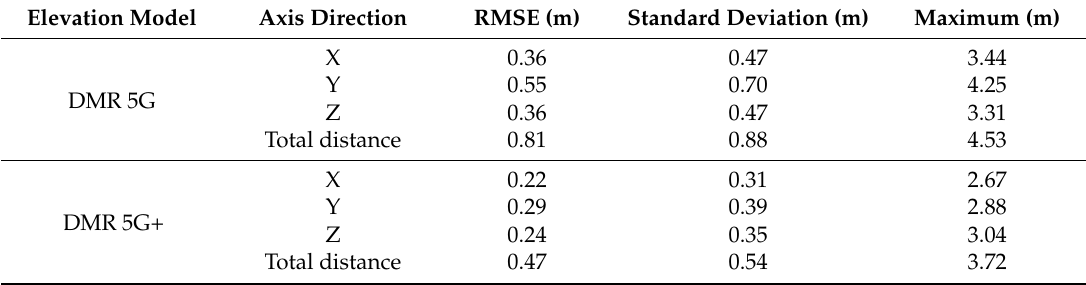
Figure 10. Comparison of 3D rock object layout and distance from DMR 5G (( A ) looking from the south; ( B ) looking from the north) and from DMR 5G+ (( C ) looking from the south; ( D ) looking from the north) (m). Table 4. Distances of DMR 5G and DMR 5G+ models with single-axis distribution calculated from a comparison of closest neighbors of point cloud models (RMSE means root mean square error)